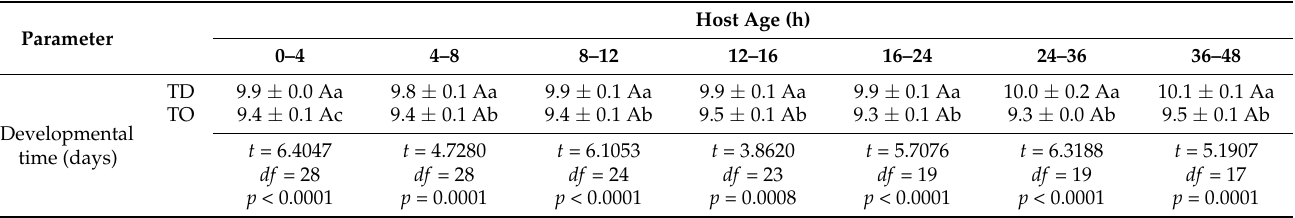
Table 3. Developmental time of Trichogramma dendrolimi (TD) and Trichogramma ostriniae (TO) on Asian corn borer (ACB) eggs of different